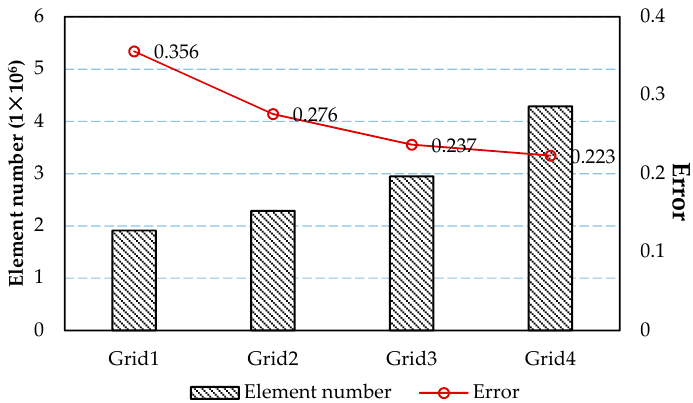
Figure 19. Results of mesh convergence study.